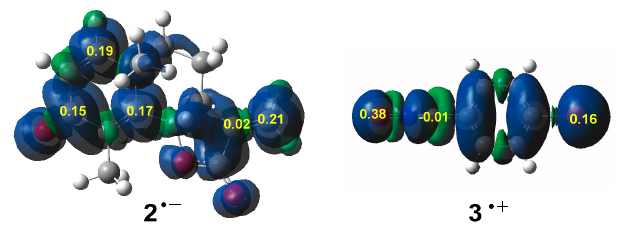
Figure 2. Three-dimensional representation of the Mulliken atomic spin densities (MASDs) (isovalue = 0.0004) of radical anion 2 − and radical cation 3 + , together with the electrophilic P + Parr functions of α -santonin derivative 2 and the nucleophilic P − Parr functions of nitrile oxide 3 . Blue regions correspond to positive values of the MASD, while green regions correspond to negative values of the MASD.